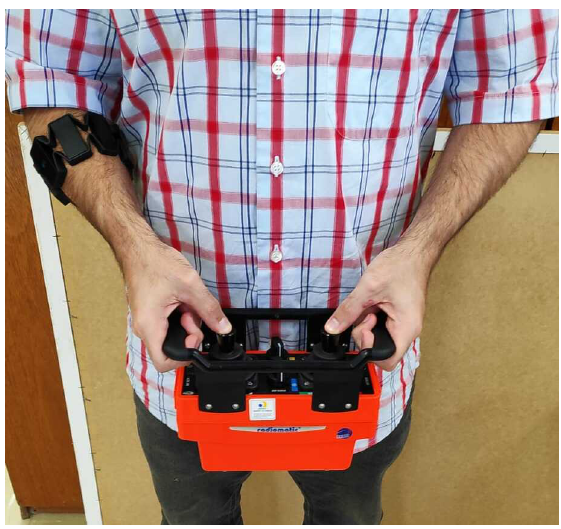
Figure 11. Robot controls. There is a fusion between data from an industrial joystick and a Myo armband to control the robot.